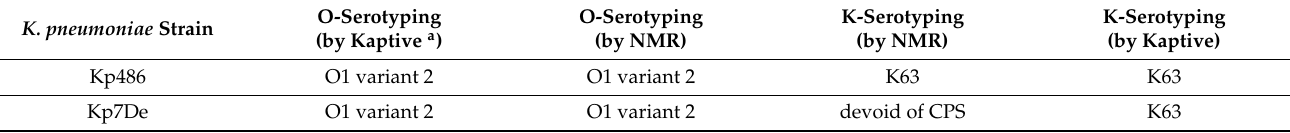
Table 1. LPS and CPS identification and serotyping in K. pneumoniae Kp486 parental strain and Kp7De mutant. K. pneumoniae